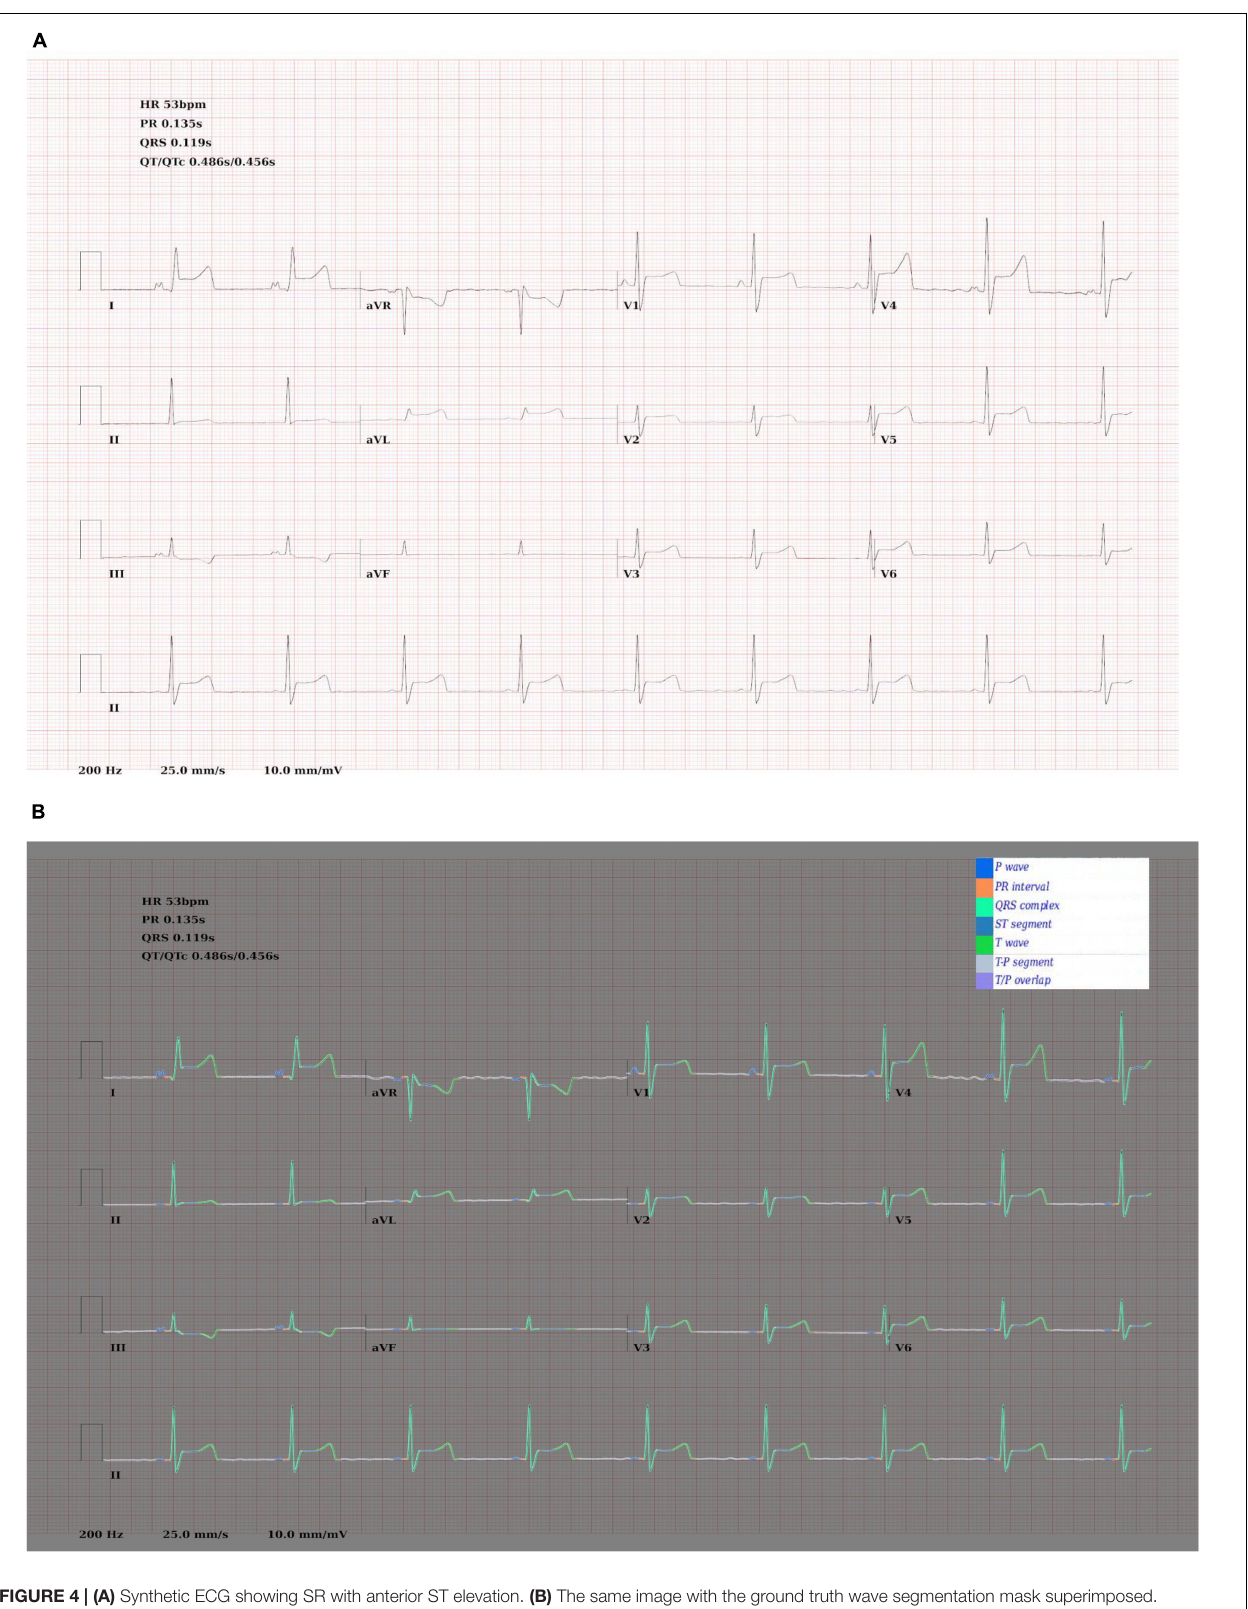
FIGURE 4 | (A) Synthetic ECG showing SR with anterior ST elevation. (B) The same image with the ground truth wave segmentation mask superimposed.